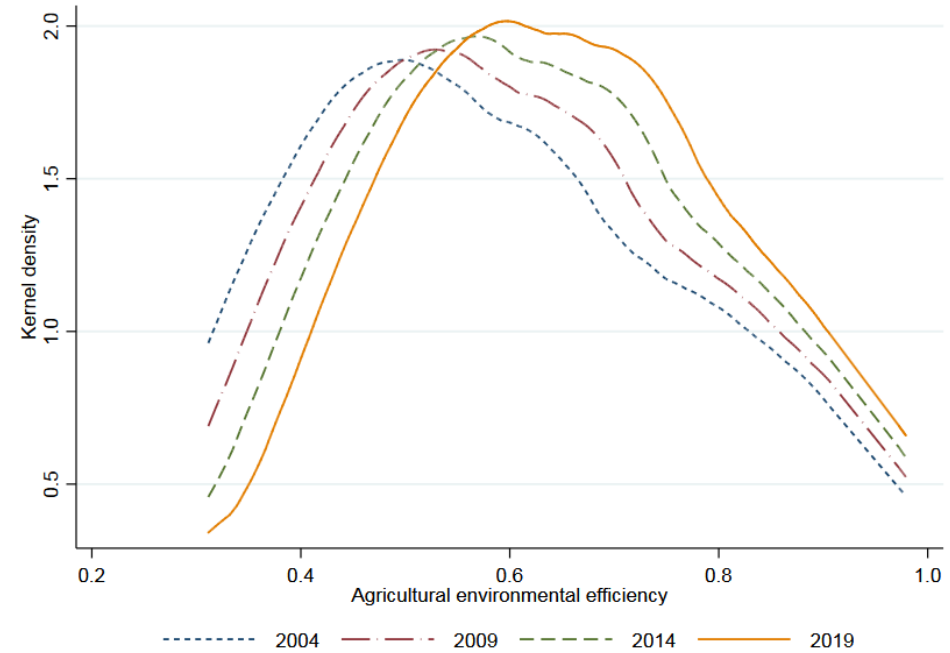
Figure 3. Kernel density of agricultural environmental efficiency.